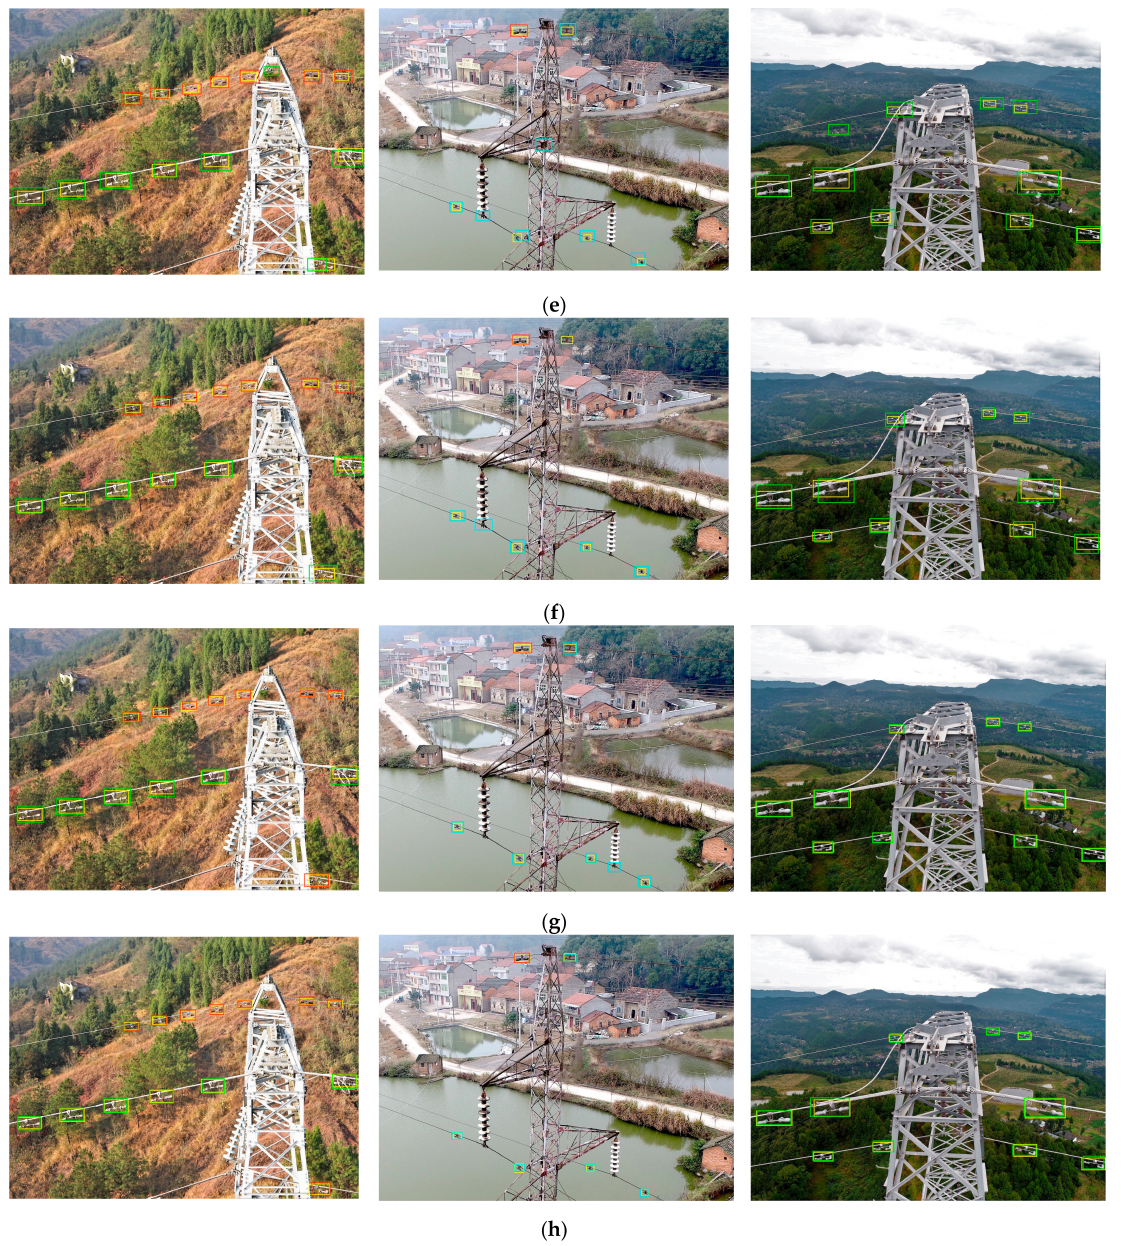
Figure 20. Visualization of the test results for the mainstream object detection networks: ( a ) SSD512; ( b ) Faster R-CNN + FPN; ( c ) RetinaNet; ( d ) Cascade R-CNN+; ( e ) YOLOv3; ( f ) YOLOv4; ( g ) YOLOv5x; ( h ) PMA-YOLO. The ground truth boxes and the prediction boxes for “rusty”, “defective”, and “normal” dampers are shown in yellow, red, blue, and green,